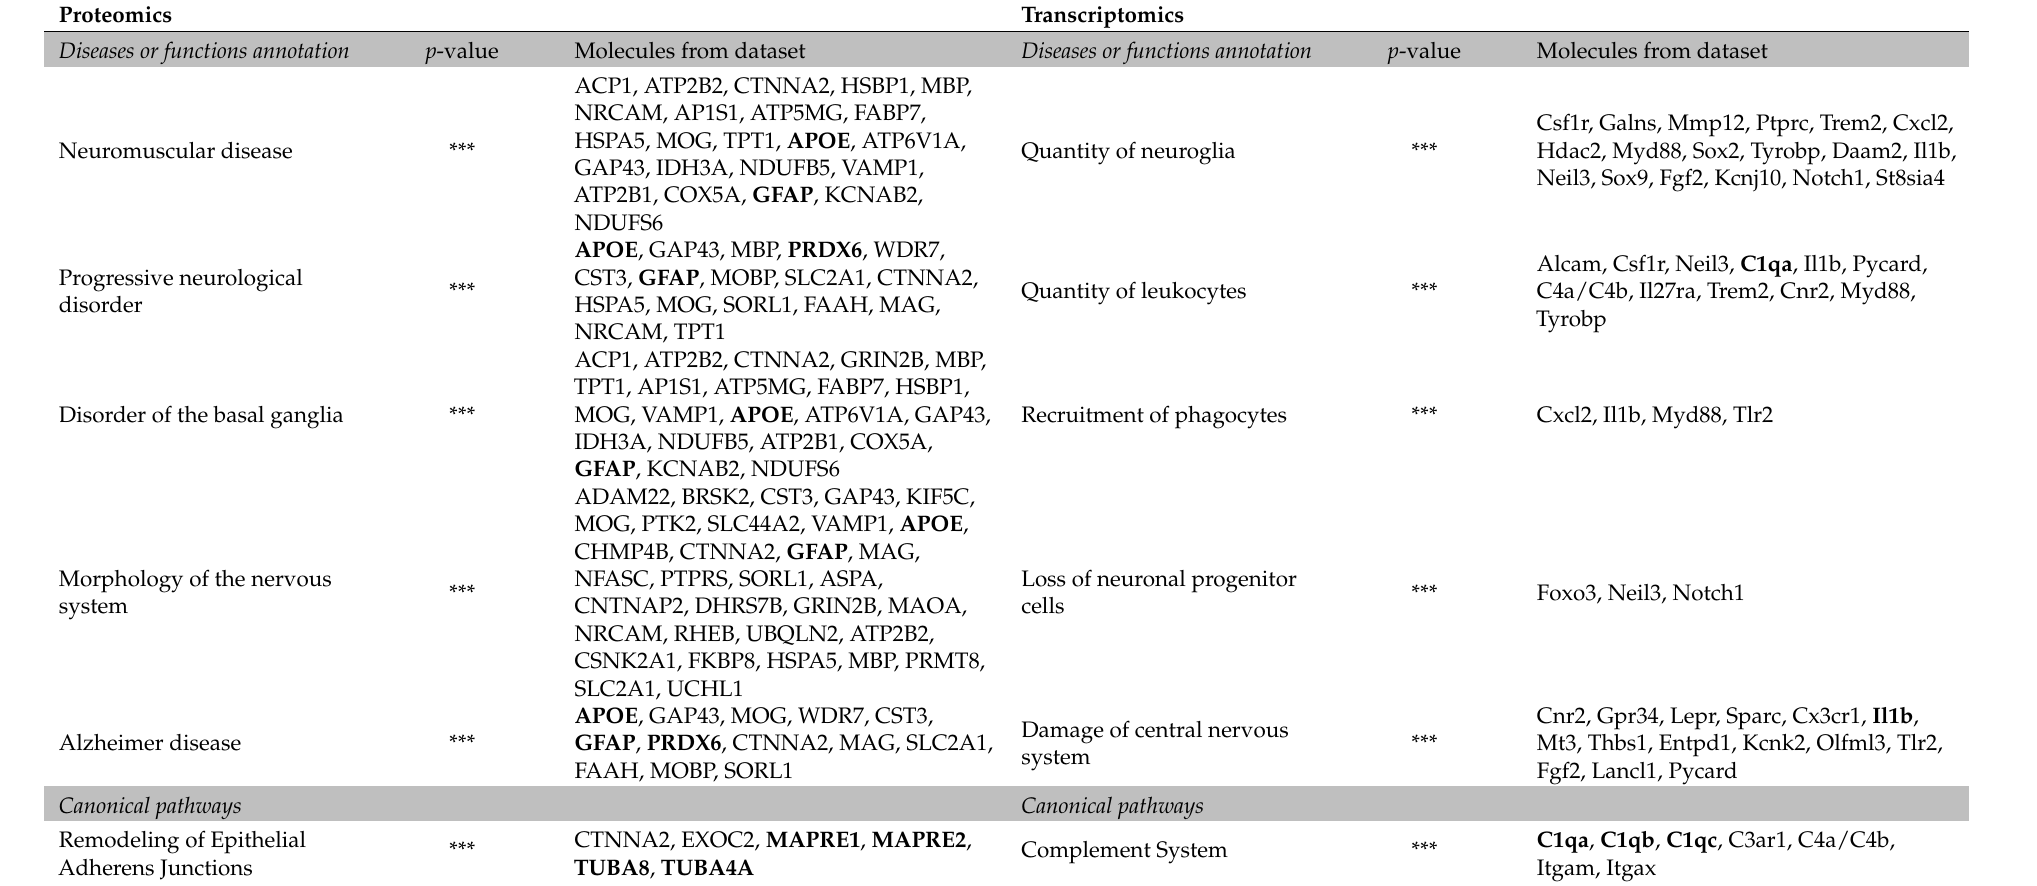
Table 3. Summary of diseases/functions, canonical pathways and upstream regulators from Ingenuity Pathway Analysis (IPA) based on the proteins (149 proteins) and RNA transcripts (916 RNA) showing significant ( p < 0.05) interaction effects between SeMet and MeHg HD, listed according to p -values calculated by the software. Features in bold represent examples of proteins and RNA transcripts involved in cell plasticity, oxidative stress, immune response and